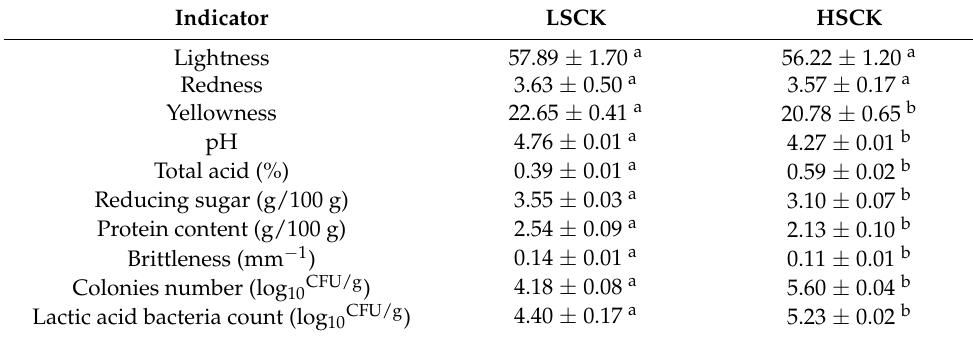
Table 1. The physicochemical and microbial properties between LSCK and HSCK.